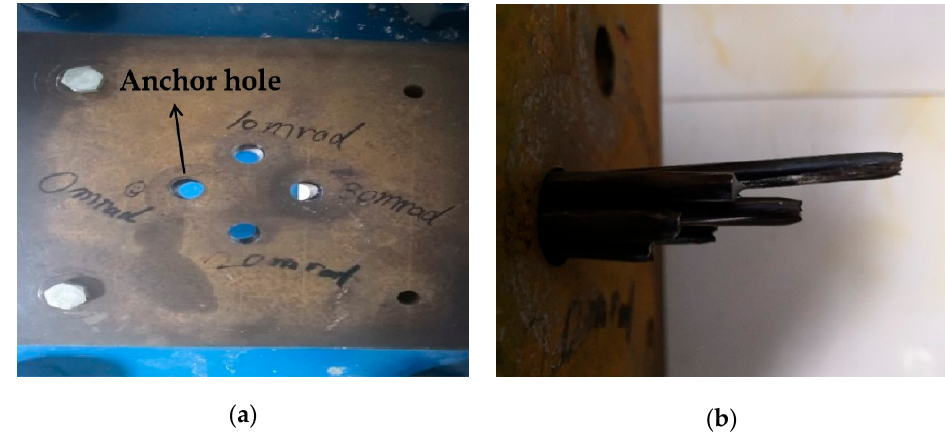
Figure 16. Lateral bending of the seven-wire strands in the test.